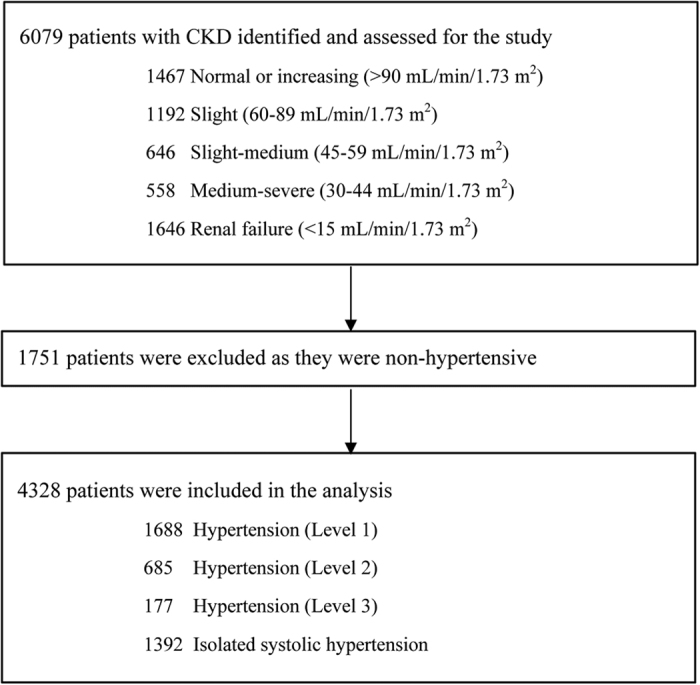
Study Flow Chart.